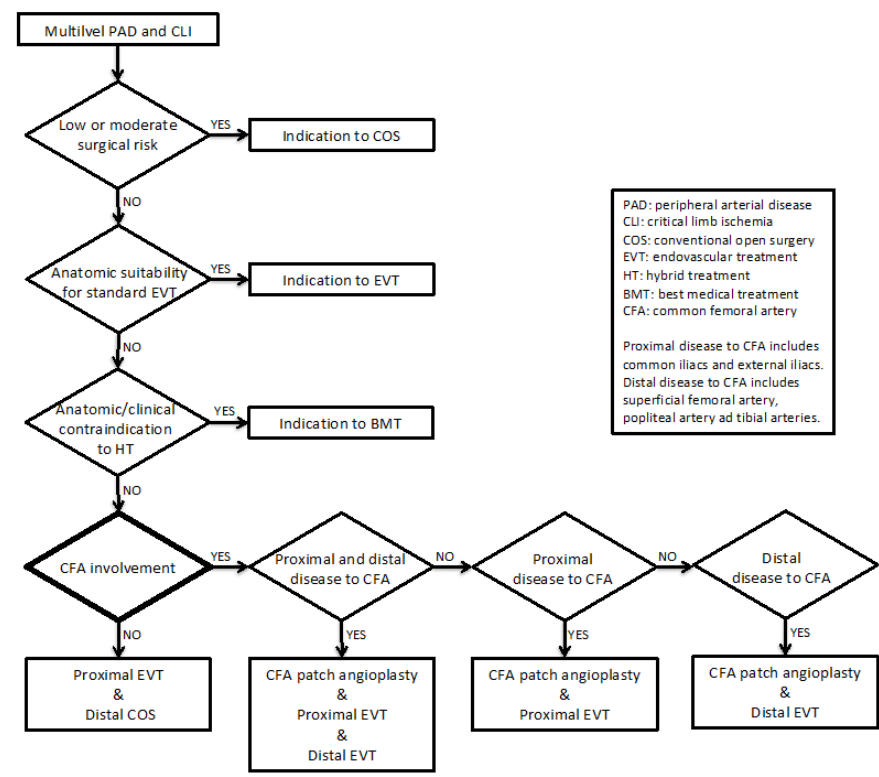
Figure 1. Flow-chat showing the decisional algorithm employed in patients presenting chronic limb-threatening ischemia with multilevel peripheral arterial